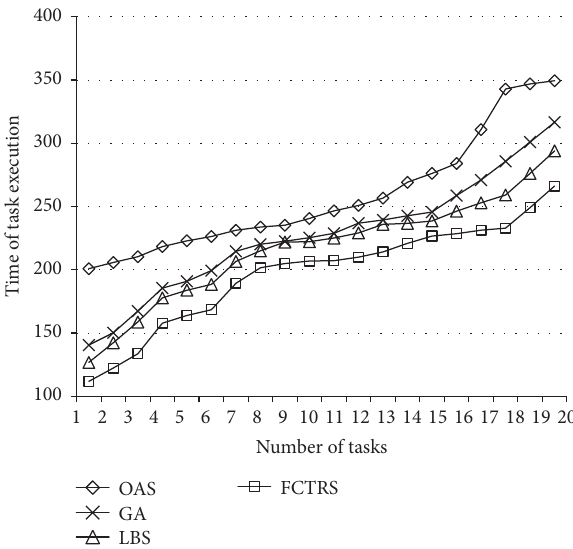
Figure 10: The makespan of each task using different resource scheduling strategies.